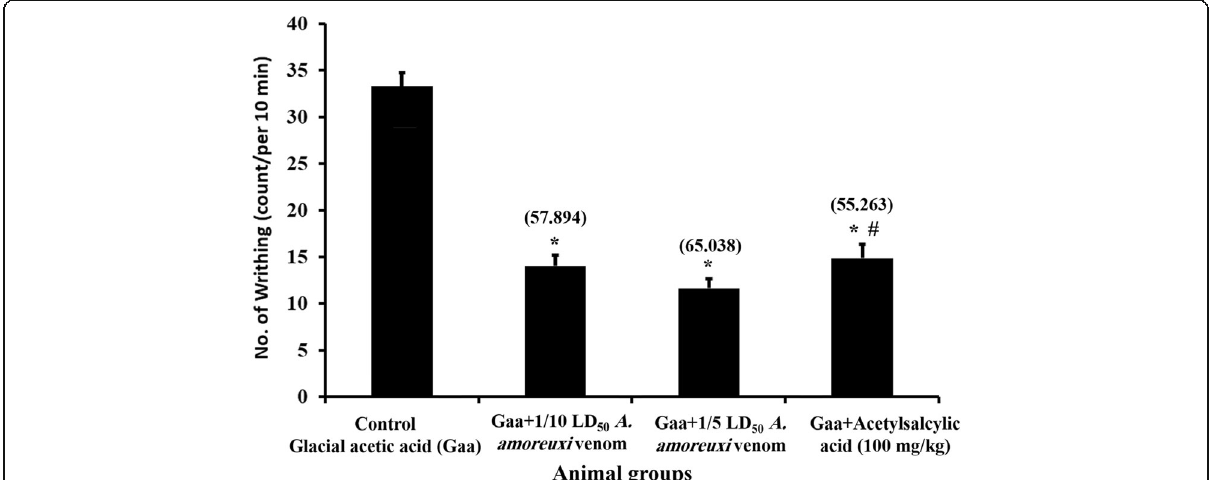
Fig. 1 Analgesic effect of 1/10 and 1/5 LD 50 of A. amoreuxi venom (0.11 and 0.22 mg/kg, respectively) using glacial acetic acid (Gaa)-induced abdominal writhing in mice. Data are presented as mean ± SEM (6 animals / group). (*) represents a significant difference between Gaa control and treated groups using Student ’ s unpaired t test ( p < 0.05). (#) represents a significant difference between all groups using one-way ANOVA ( p ≤ 0.05). Values between brackets are pain inhibition percentage (%PIP)